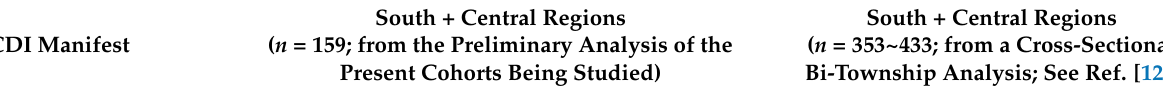
Table 3. The R-squared analysis for any different attribute(s) on the CCDI